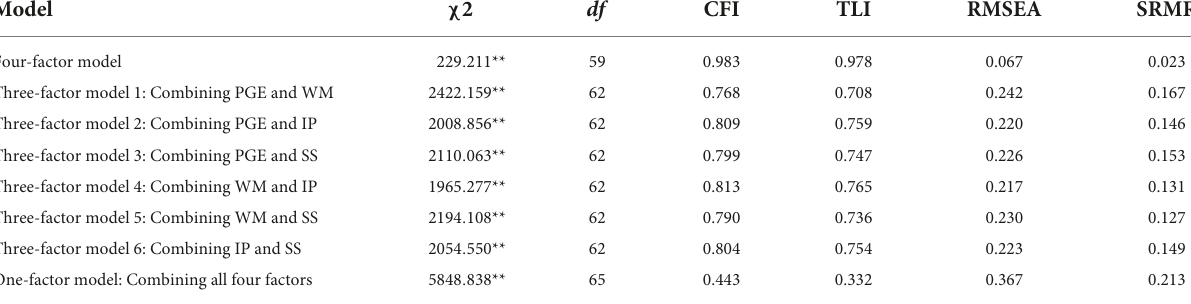
TABLE 2 Results of the confirmatory factor analysis (CFA).